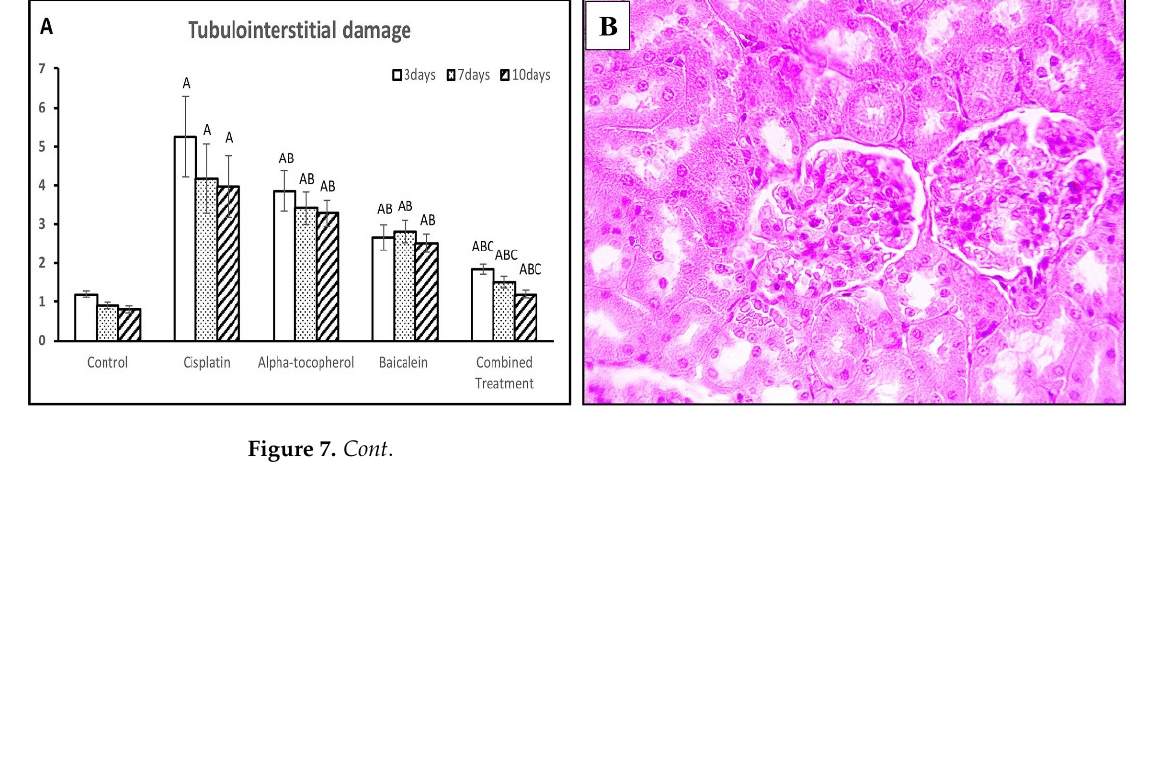
Figure 7. Microscopic pictures of H&E-stained renal sections showing ( A ) tubulointerstitial damage score in treated groups, Significant vs. control group refers to A, while significant vs. (cisplatin, - tocopherol, and baicalein) treatment groups refers to (B, C, D), respectively, ( B ) normal cortex and medulla in the control group, ( C ) leukocytic cell infiltration (star) and dilated tubules (black arrow) in cisplatin group, ( D ) mitotic figure (white arrow) in α -tocopherol group, ( E ) mitotic figure (white arrow) in baicalein group, and( F ) prominent nuclei (arrowhead) in combined treatment group. High magnification ×: 400 bar 50